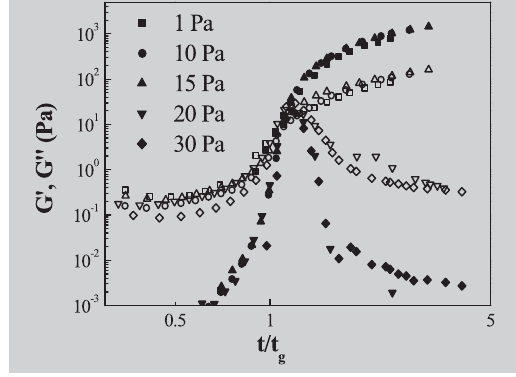
Figure 4 (left): Storage ( Ê ) and loss ( Á ) shear moduli as a function of time reduced by t for a g submicelle solution at C = 120 g/L heated at 80ºC obtained for different maxi- mum imposed shear stresses indicated in the figure. Figure 5: The left panel compares the applied stress ( Á ) with the strain (Δ) response during an oscillatory cycle of a sub- micelle solution at 120 g/L at different values of t/t g indicated in the figure. The corresponding Lissajous plots (strain versus stress) are shown in the right